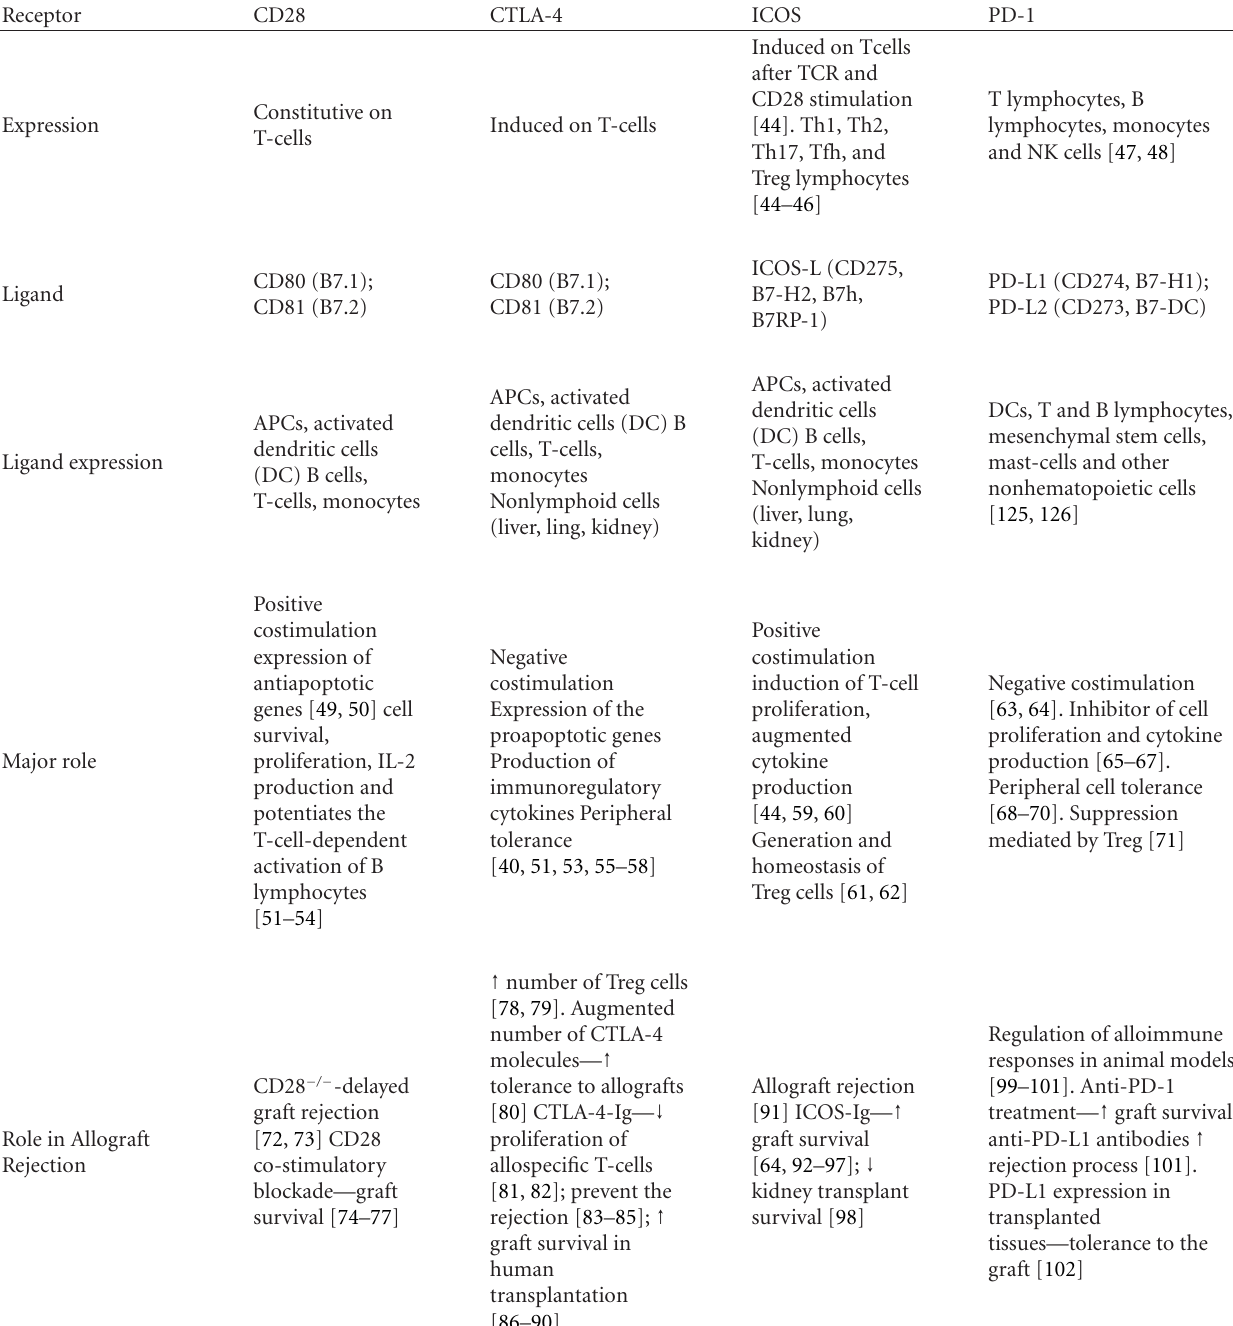
Table 1: Expression of CD28 family members, ligands, and targeting in